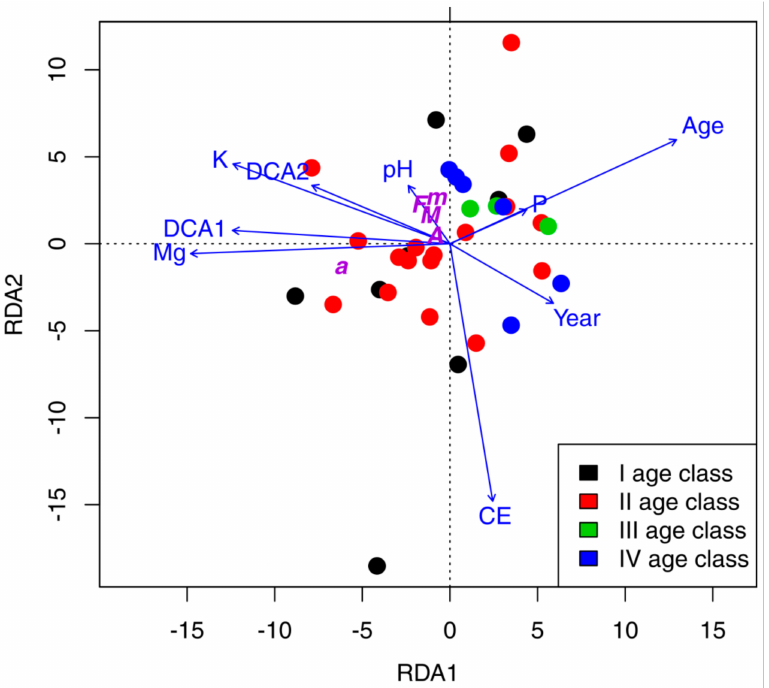
Figure 3. Tri-plot of RDA based on mycorrhizal parameters showing samples in four classes of age (1–4) and environmental factors.